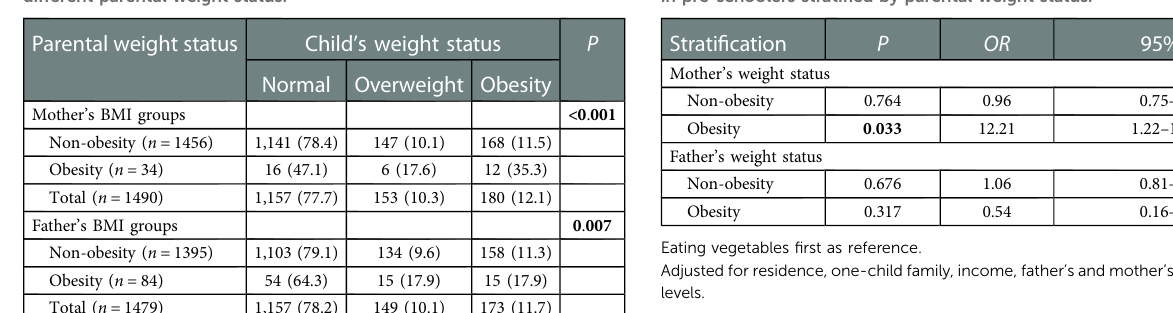
TABLE 4 The effect of eating meat/ fi sh fi rst on risk of overweight/obesity in pre-schoolers strati fi ed by parental weight